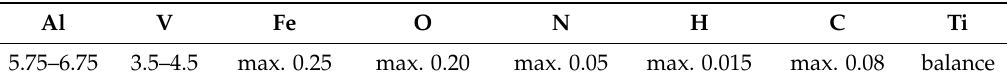
Table 1. Chemical composition of powder used (wt.